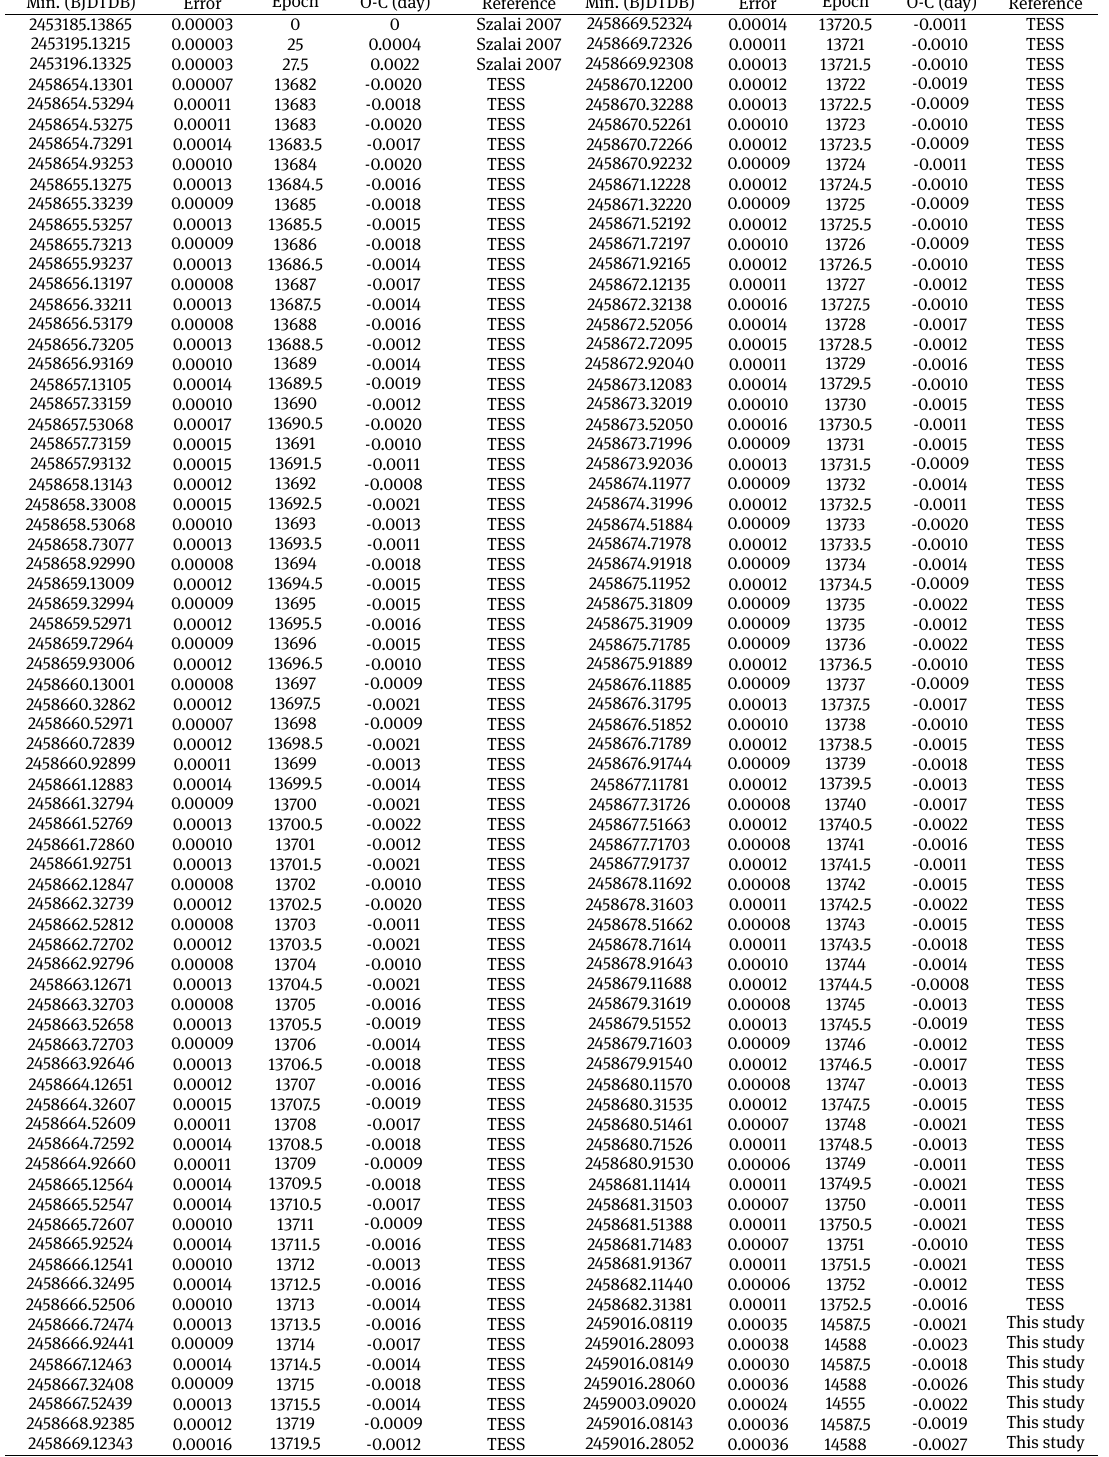
Table 2. Times of minima of V870 Ara (we ignored the literature’s minimum times of three and less than three decimal places to improve accuracy) Min.